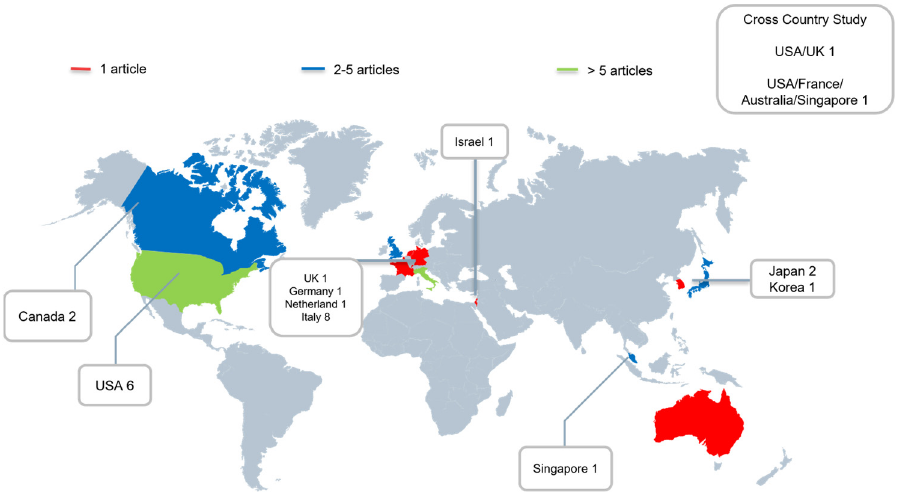
Figure 2. Geographic distribution of the included articles.